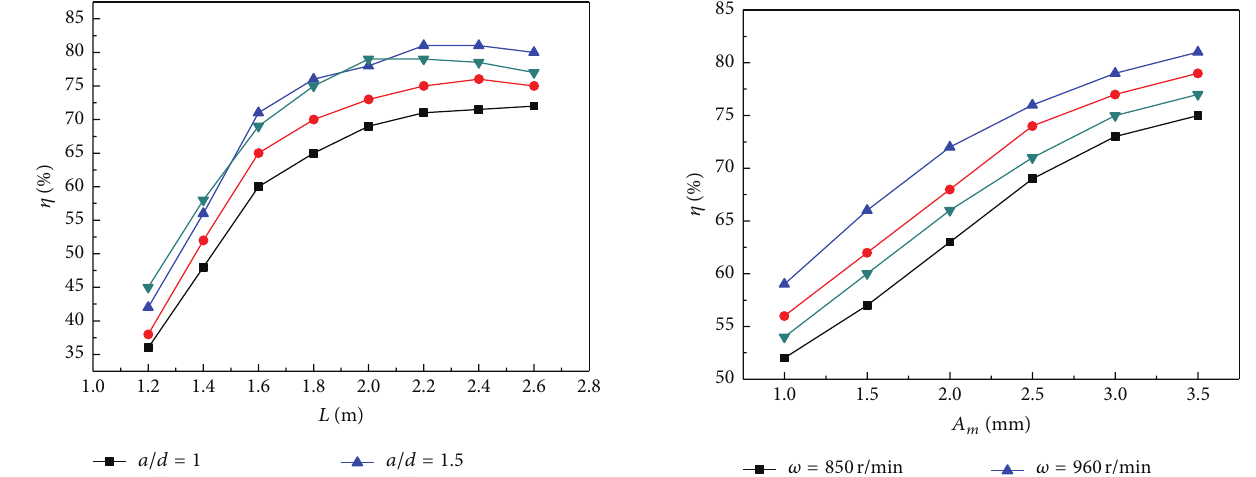
𝐿 is shorter due to the high penetration probability of the particles whose size is smaller than separation size during the beginning time of sieving. The optimum range of screen length is between 2.0 m and 2.6 m.